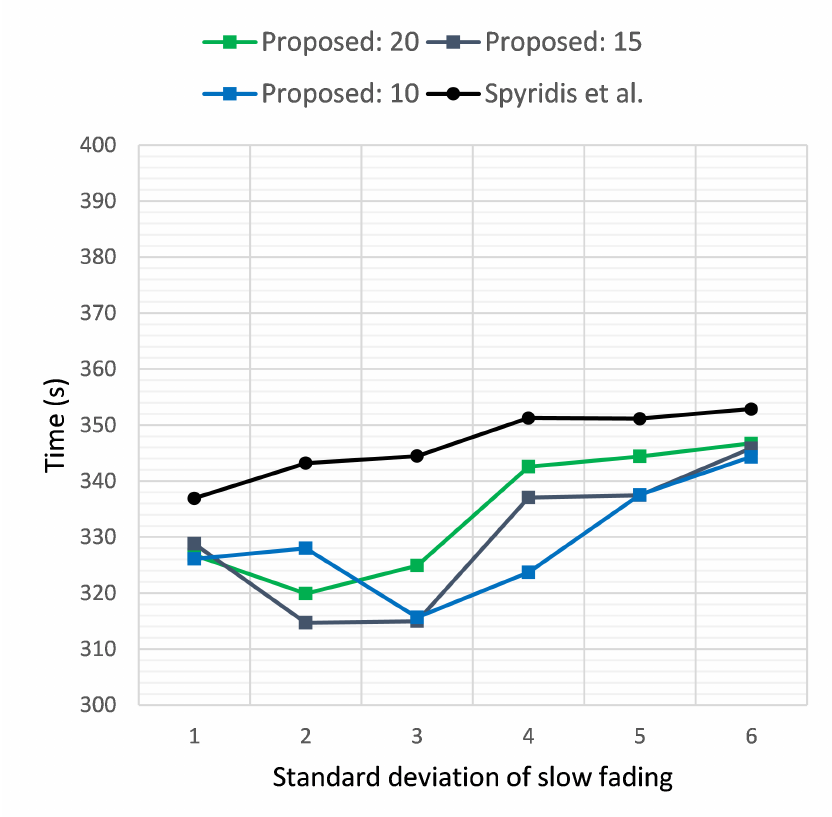
Figure 6. Time required for the first UAV to reach the target sensor when placed at a distance of 3 km, versus the standard deviation σ of the additive noise. Comparison of the proposed method at clustering termination thresholds of 20, 15 and 10 dB and the previous